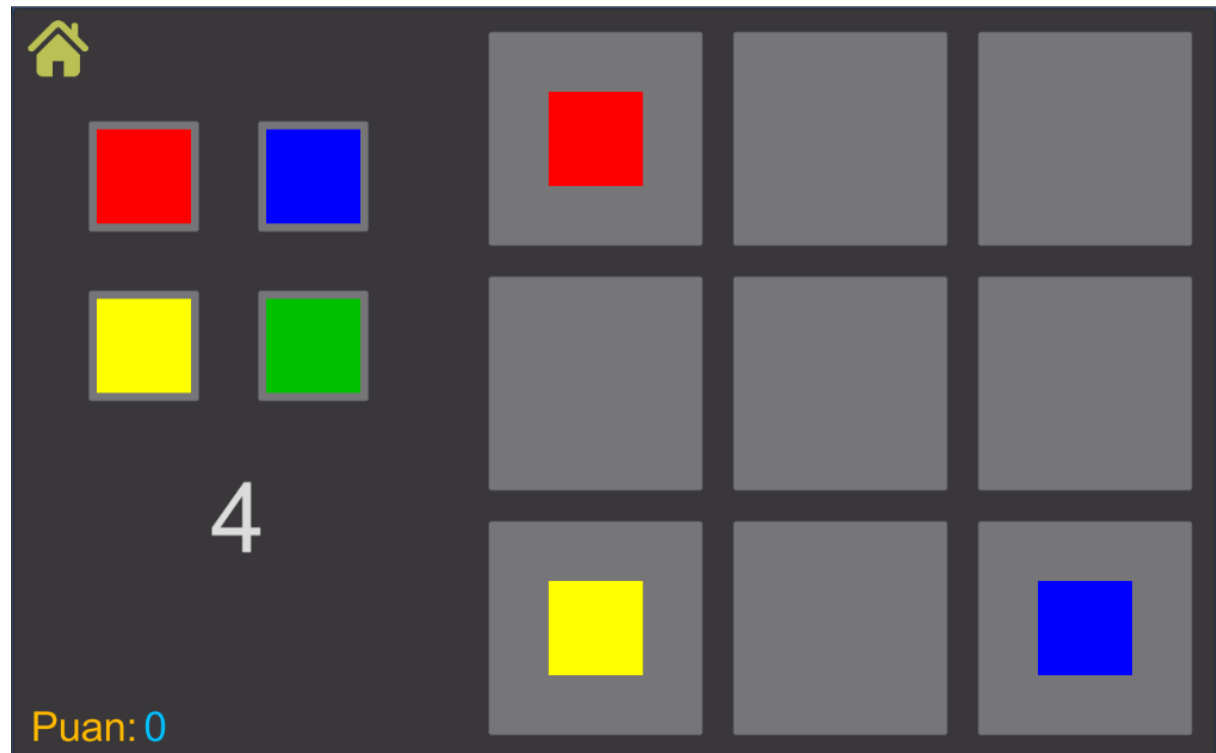
Figure 2. Screenshot of the Memory game from Prototype